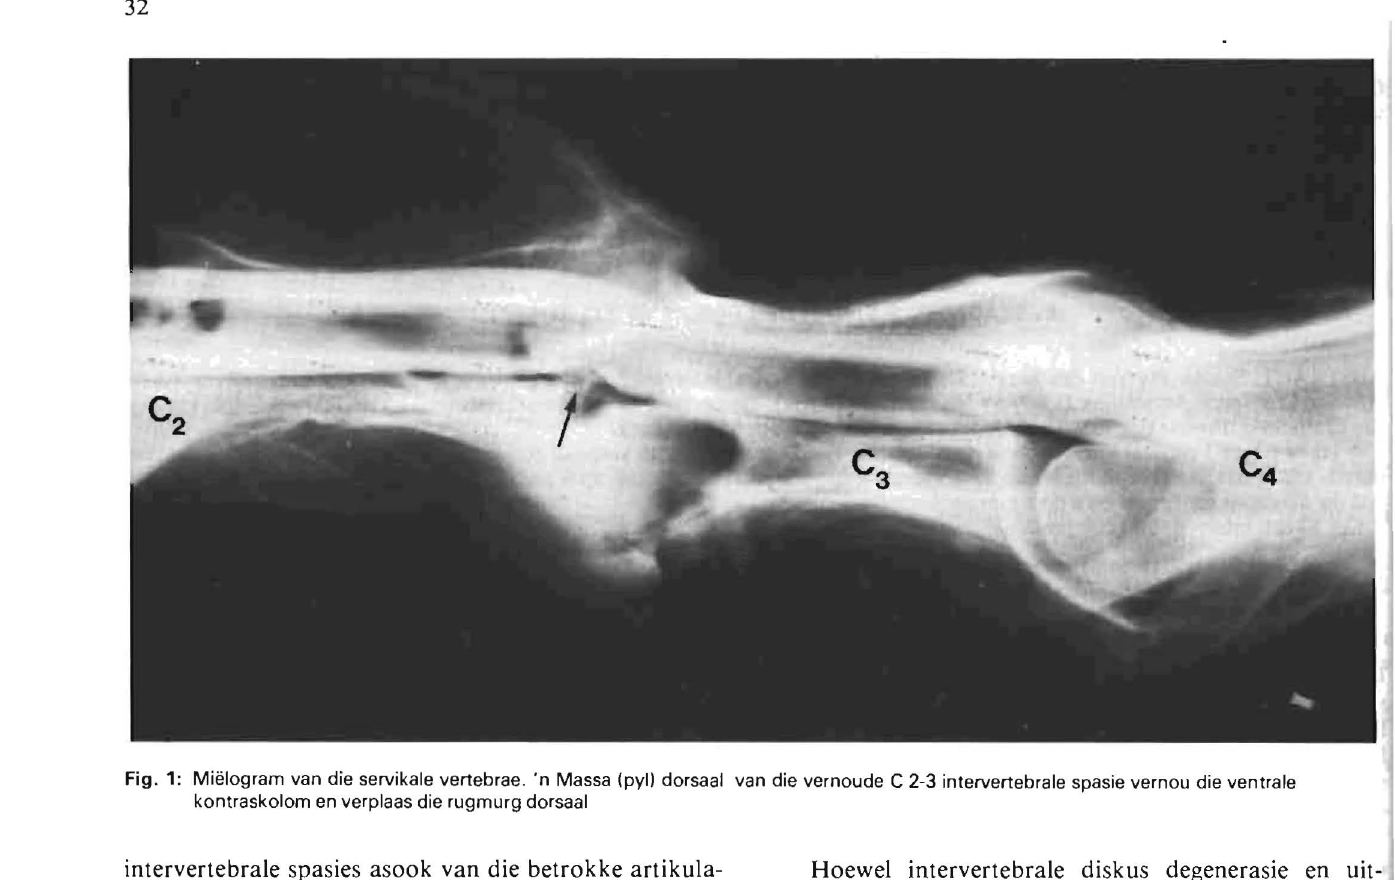
Fig. 1: Miiilogram van die servikale vertebrae. 'n Massa (pyl) dorsaal van die vernoude C 2-3 intervertebrale spasie vernou die ventrale kontraskolom en verplaas die rugmurg dorsaal intervertebrale spasies asook van die betrokke artikula